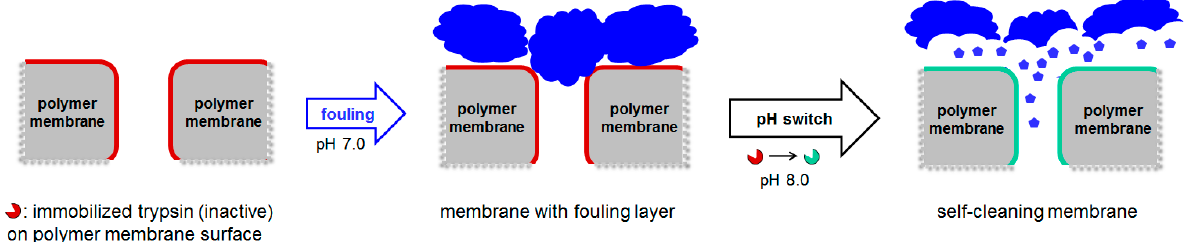
Figure 2. Schematic concept of the self-cleaning membrane: the digestive enzyme trypsin was immobilized on the membrane surface to enable the active degradation of a protein fouling layer at an optimum pH range of 7.5–8.5.